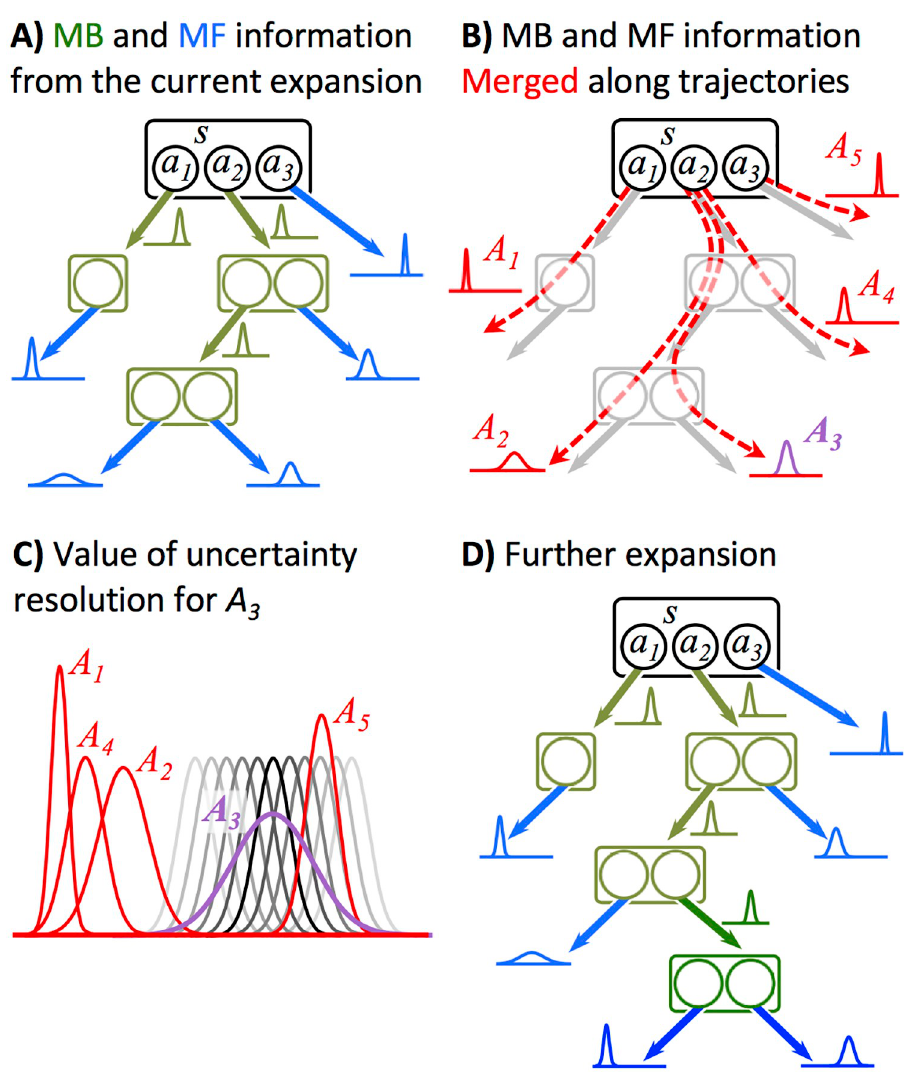
Fig 1. Overview of the pruning scheme, illustrated via an example. (A) A snapshot of the search tree. Nodes of the tree represent states, and each state has a number of available actions, denoted with circles, that lead to next states. Blue graphs show value distributions for the leaves of the tree, estimated by the model-free (MF) or any other heuristic system. Green graphs show the immediate rewards for previously expanded state-actions, estimated via the model- based (MB) system. (B) Each path from the root to a leave forms a strategy, A i , with a corresponding value distribution. These distributions are obtained by summing up the value distributions of the leaves with the immediate reward distributions accumulated along the way. (C) To compute the value of uncertainty resolution ( VUR ), say for A 3 , the agents assumes that one further expansion would result in a sharper value distribution (one of the black/grey distributions). The location (i.e., the mean) of the new distribution cannot be known in advance, but it can be treated as a random variable, whose distribution can be analytically obtained (Eq 14). The VUR for A 3 is therefore the expected value, over all possible sharper distributions (grey curves), of the additional rewards that can be obtained by a policy improvement in the light of that potential new information (i.e., the sharper distribution). (D) After computing VUR for all strategies A , the highest VUR (in this case, for A 3 ) is compared to the cost of expansion. If it is bigger than the cost, i the tree expands along the direction of that strategy. This corresponds to loading a new node, which is the successor state of the leaf of A 3 , from the MB system and adding it to the